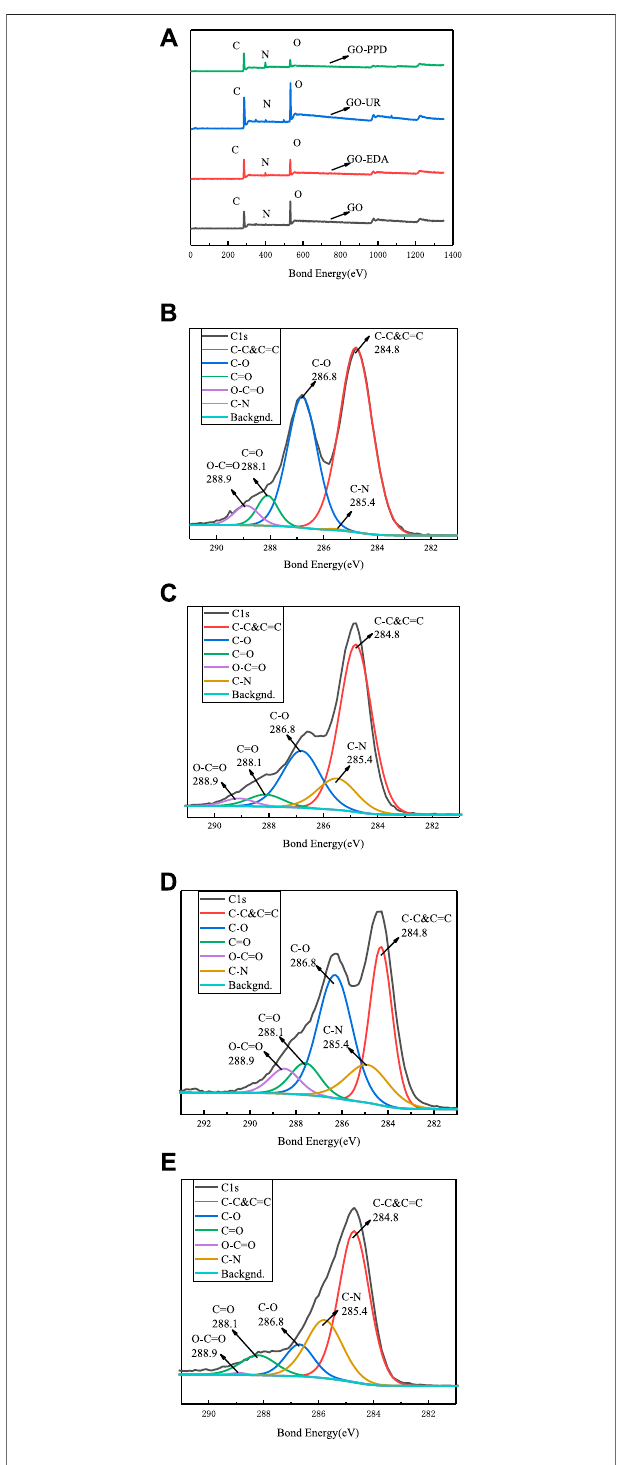
FIGURE6|(A) XPStotalspectrumoftheGO/MCE,GO-EDA/MCE,GO- UR/MCE, and GO-PPD/MCE composite membranes; XPS C1s spectrum of the GO/MCE membrane (B) , GO-EDA/MCE membrane (C) , GO-UR/MCE membrane (D) , and GO-PPD/MCE membrane (E) .